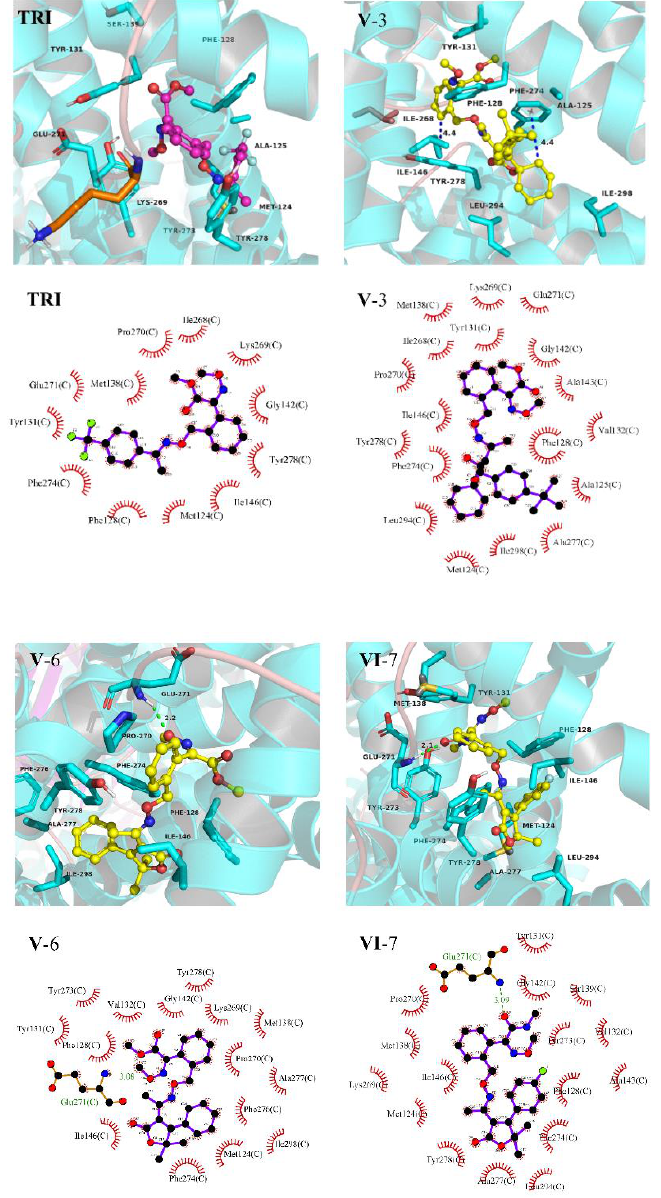
Figure 4. Interaction of compounds V - 3 , V - 6 , VI - 7 and TRI with target by molecular